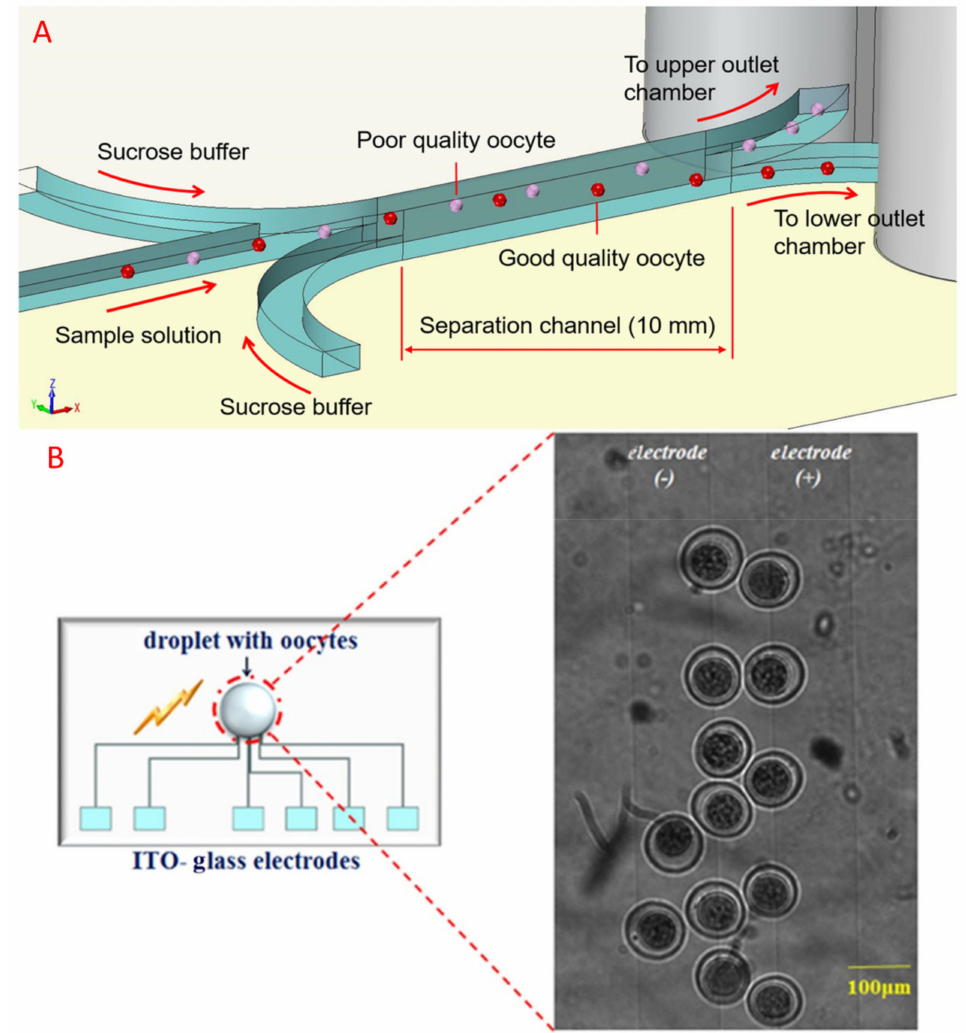
Figure 3. Various microfluidic device configurations to separate healthy oocytes. ( A ) is adapted from ref. [79] with permission from Springer Nature, and ( B ) is adapted from ref. [82] with permission from